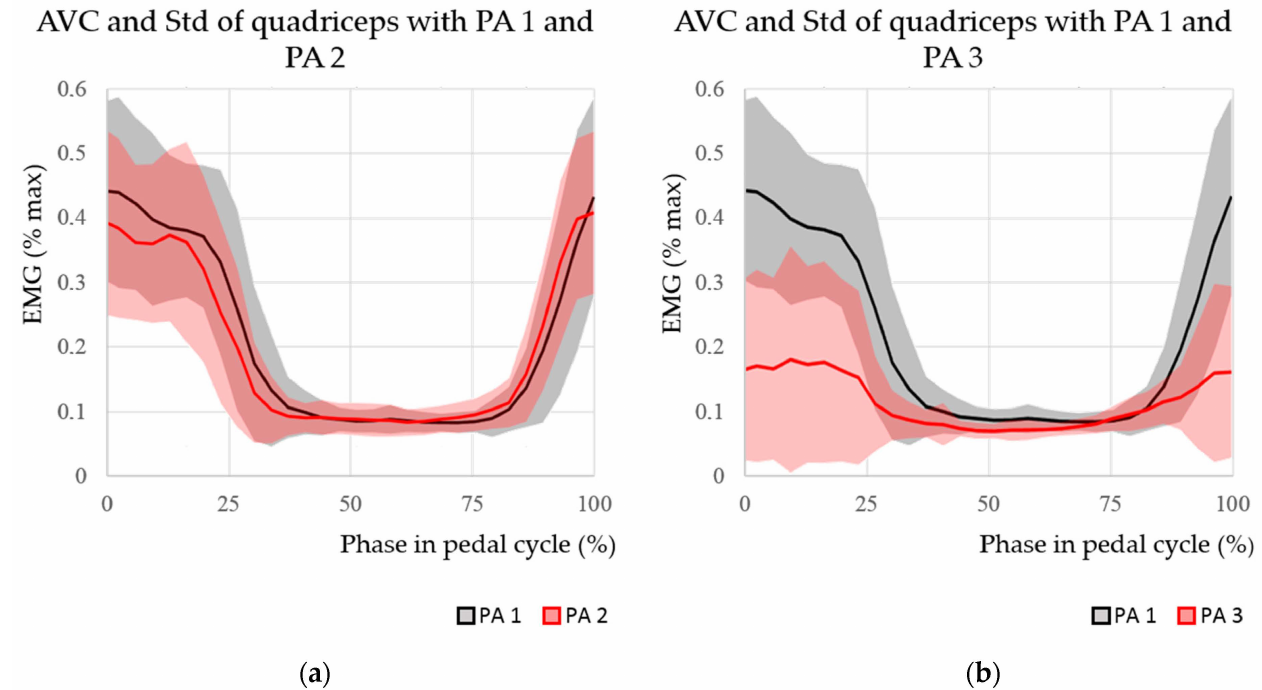
Figure 6. Ensemble average curve (AVC) of the quadriceps for pedal assistance (PA) 1 and PA 2 ( a ); and for PA 1 and PA 3 ( b